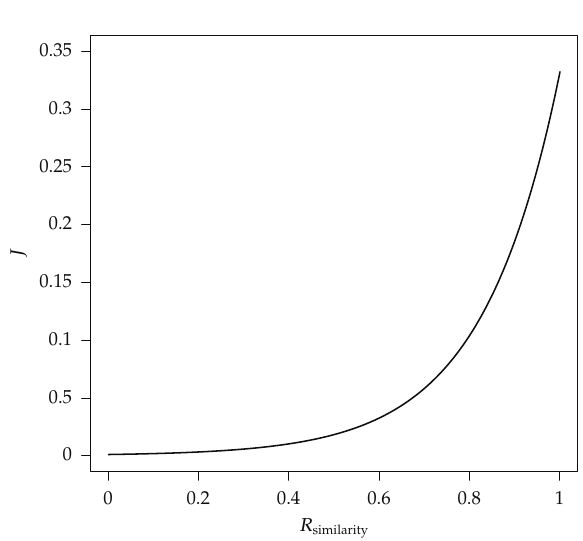
Figure 5: Exponential growth of parameter J , in relation with R similarity